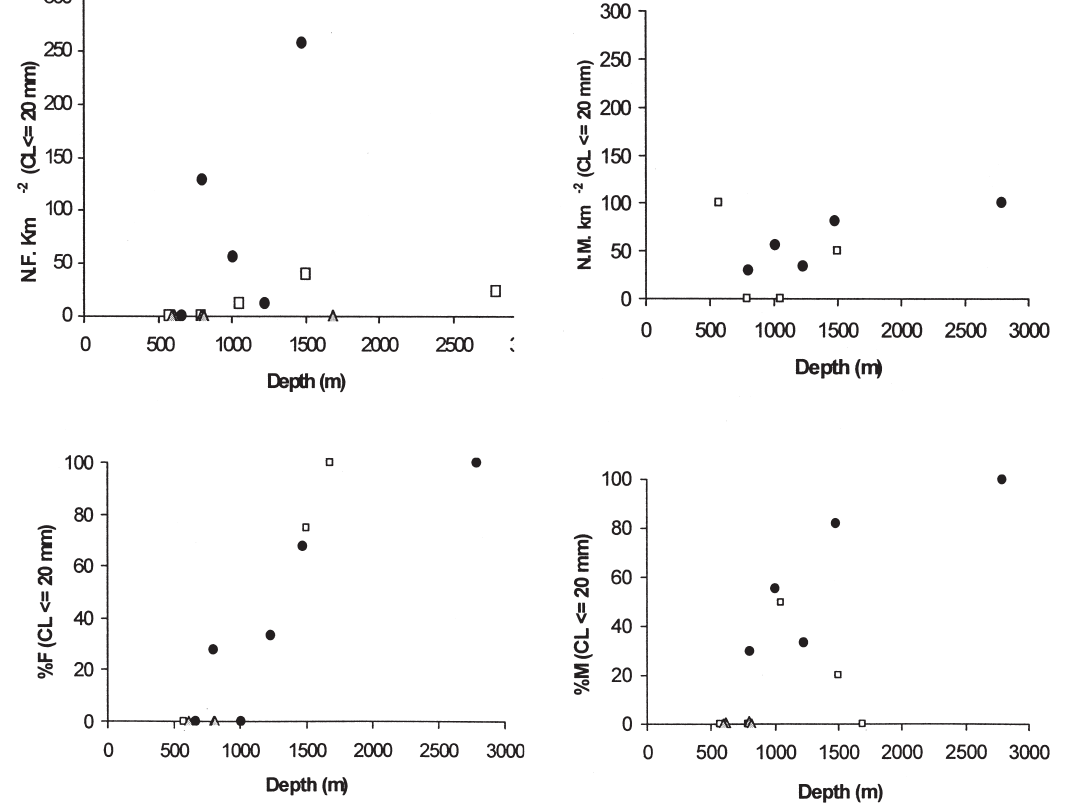
F IG . 6. – Density and percentage of juveniles (CL < 20 mm) by depth for the three sampling areas. Circle, Balearic Sea; square, western Ionian Sea; triangle, eastern Ionian DEEP-SEA DISTRIBUTION OF A. ANTENNATUS 121